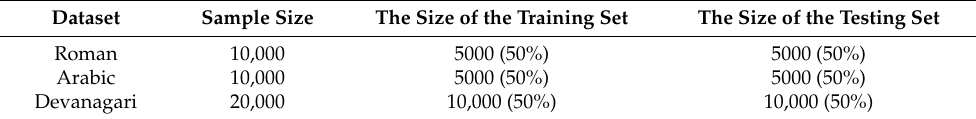
Table 1. Size of the sample for each dataset, and the size of the training and testing